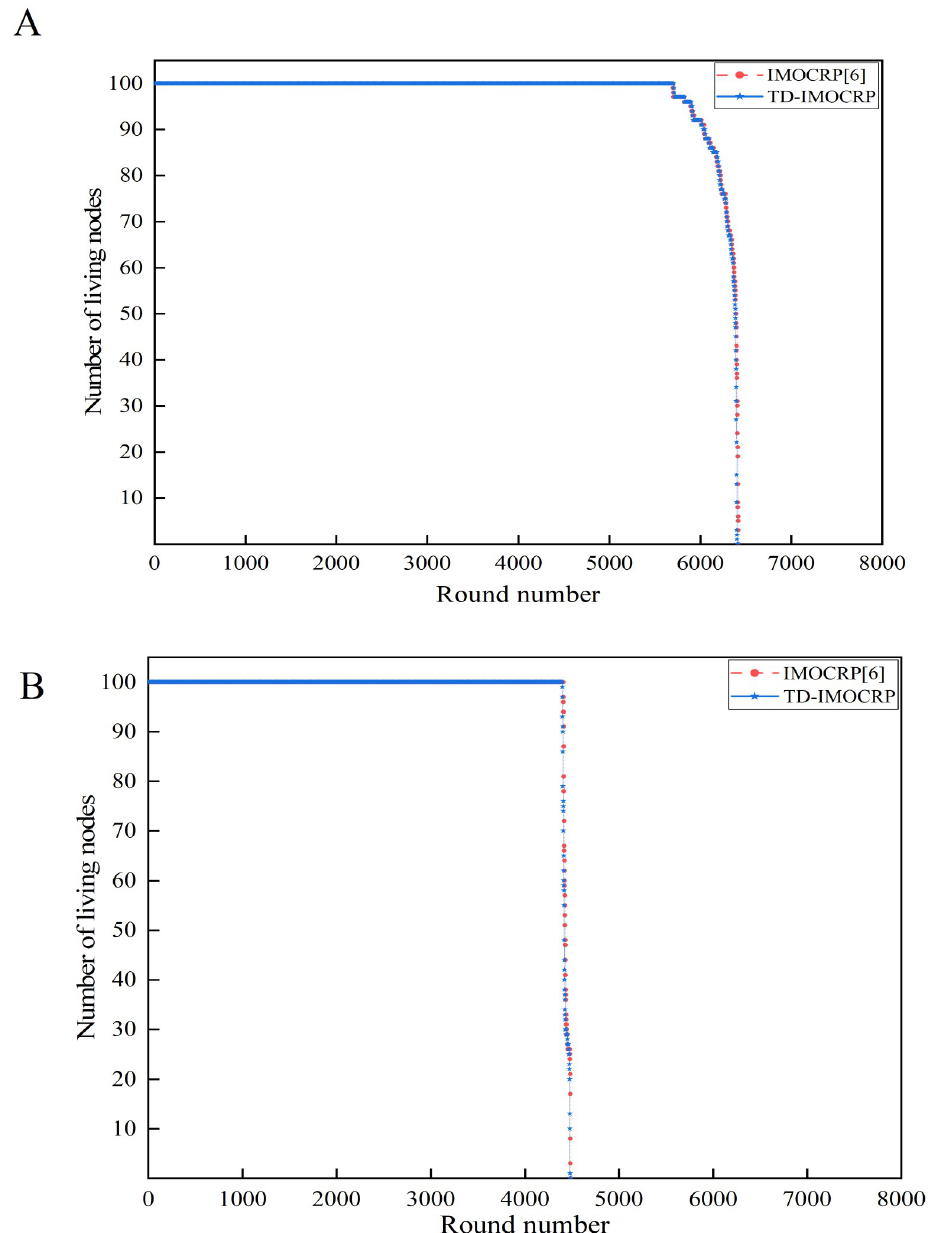
Fig 8. Comparison results of number of living nodes. (A) The sink is located at the center. (B) The sink is located at